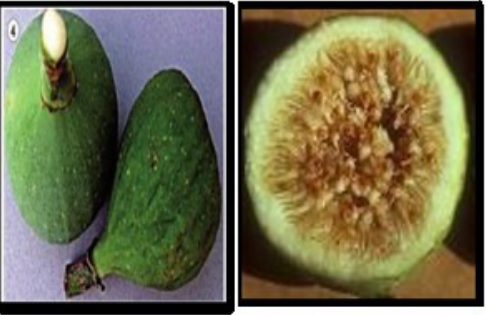
Figure 1. Fruit of Ficus carica L. (Left: whole fruit; Right: cross-section) [15,